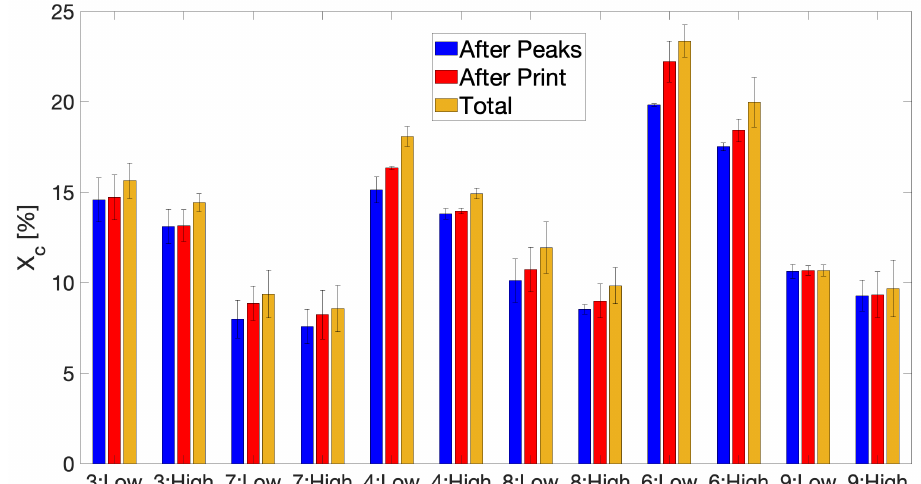
Figure 6. The comparison of the degrees of crystallinity X c after each segment of the thermal history as obtained by FSC for conditions 3, 4 and 6 printed at T build plate of 110 °C and their respective counterparts, namely conditions 7, 8 and 9, printed at T build plate of 40 °C. ‘Low’ and ‘High’ refer to layers 10 and 40,